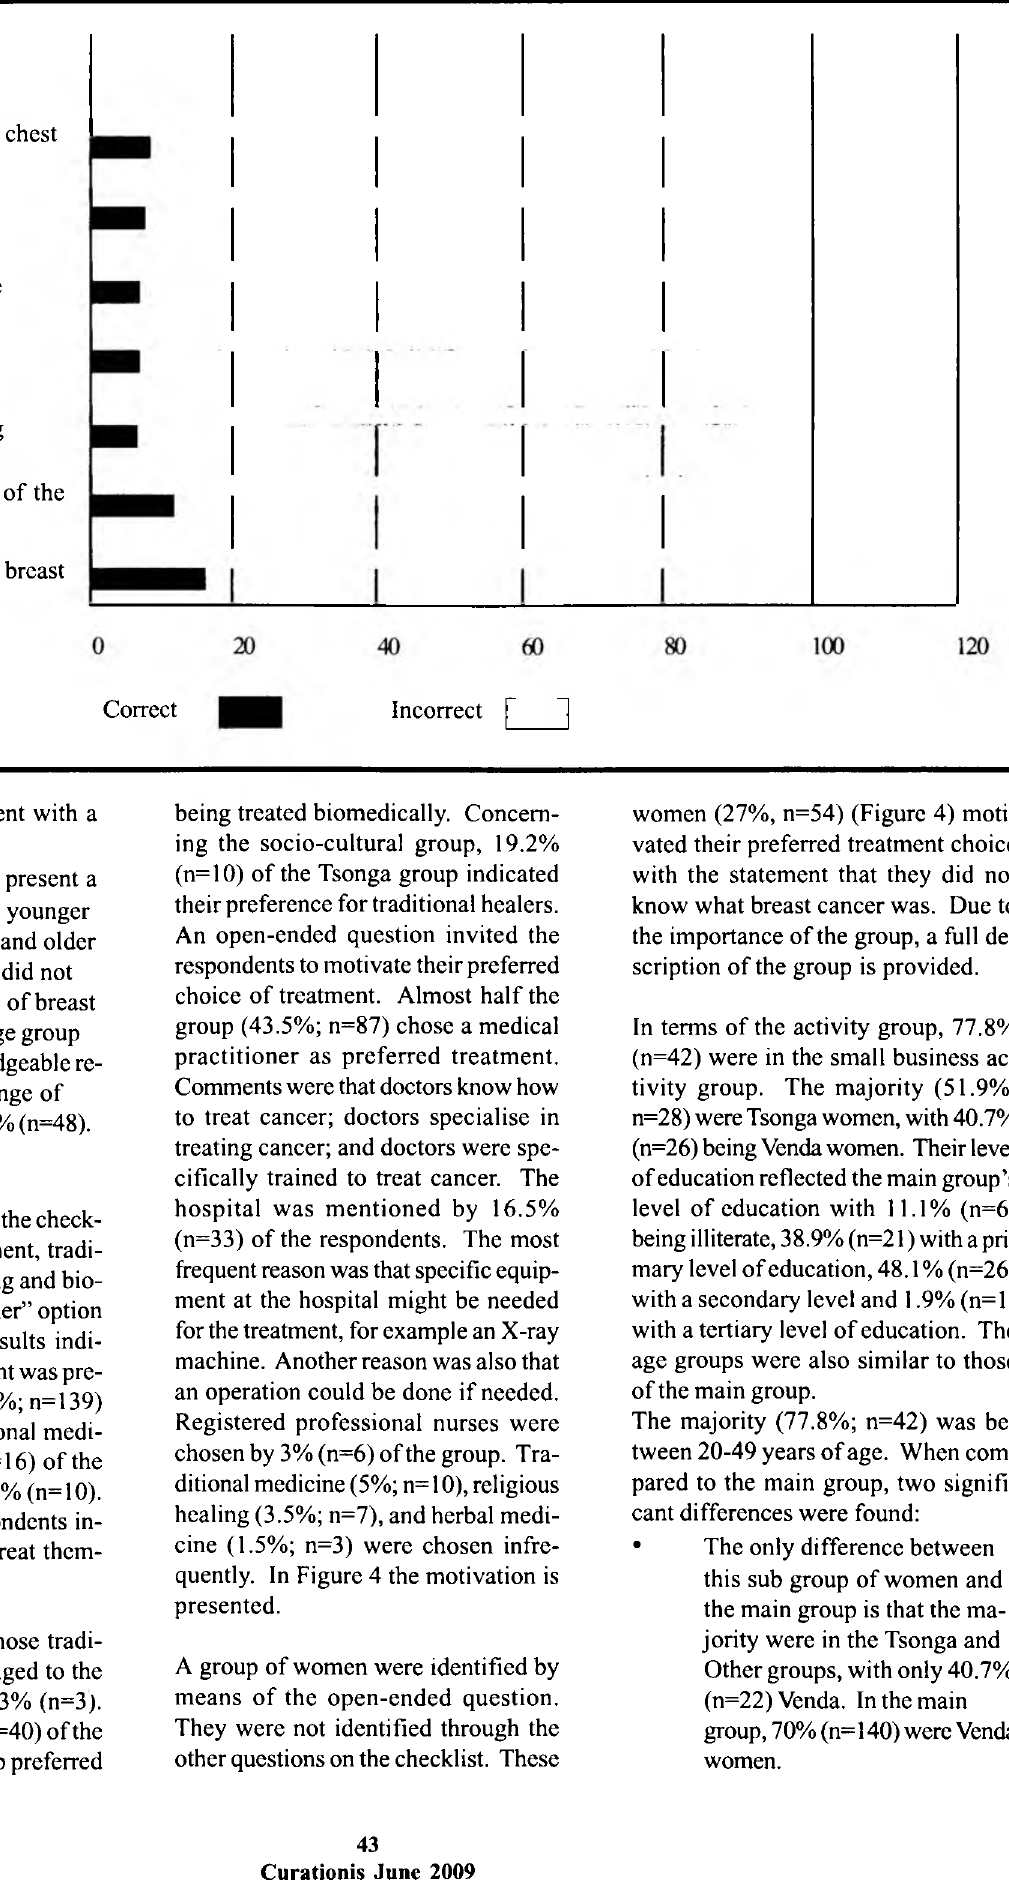
FIGURE 3: An overview of the women’s level of knowledge regarding the signs and symptoms of breast